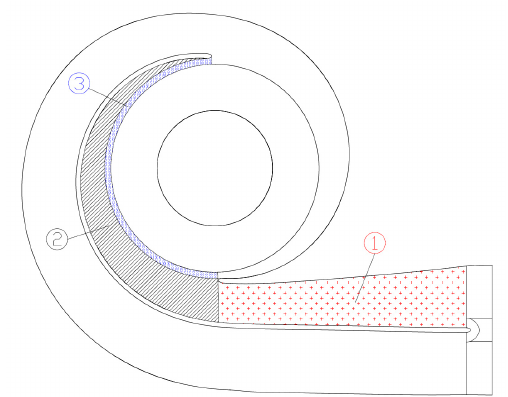
Figure 4. Division of the